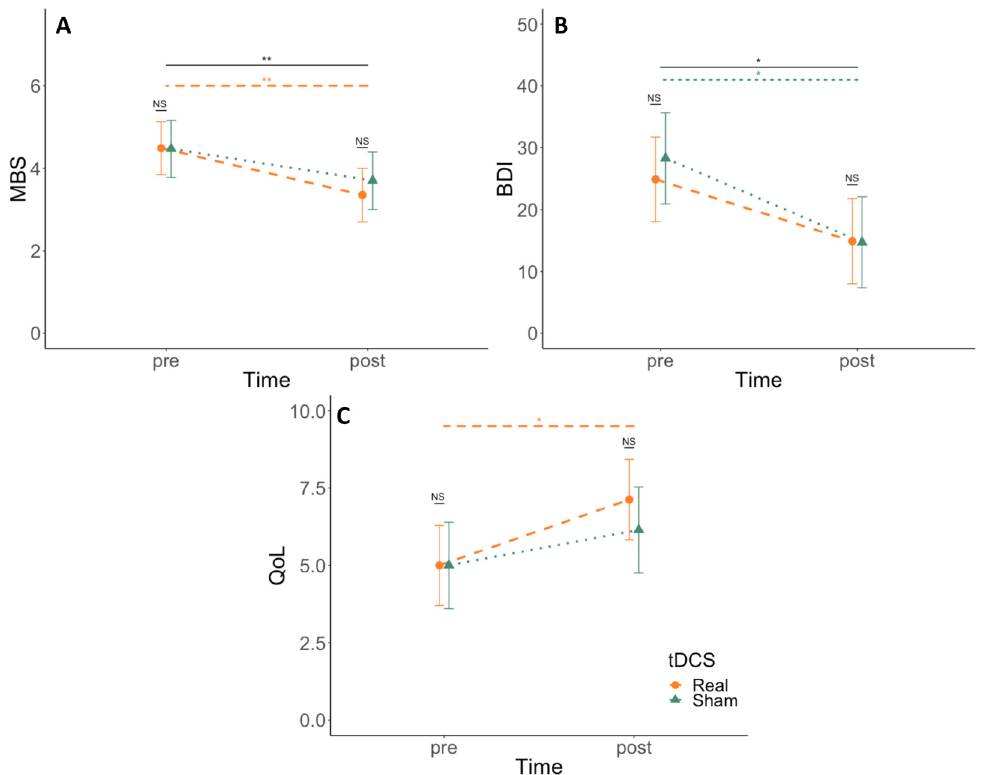
Figure 4. Mean pre- and postscores on A . the Maslach Burnout Scale (MBS), B . Beck’s Depression Inventory (BDI), and C. McGill Quality of Life (QoL) questionnaire for the sham (dotted, triangles) and real (dashed, circles) group with 95% confidence intervals. Continuous lines indicate main effects, dashed and dotted lines indicate a significant difference between the pre- and postscores of the separate group (real: dashed; sham: dotted) as found by the post-hoc analyses. NS = non-significant; * = p ≤ 0.05; ** = p ≤ 0.01.